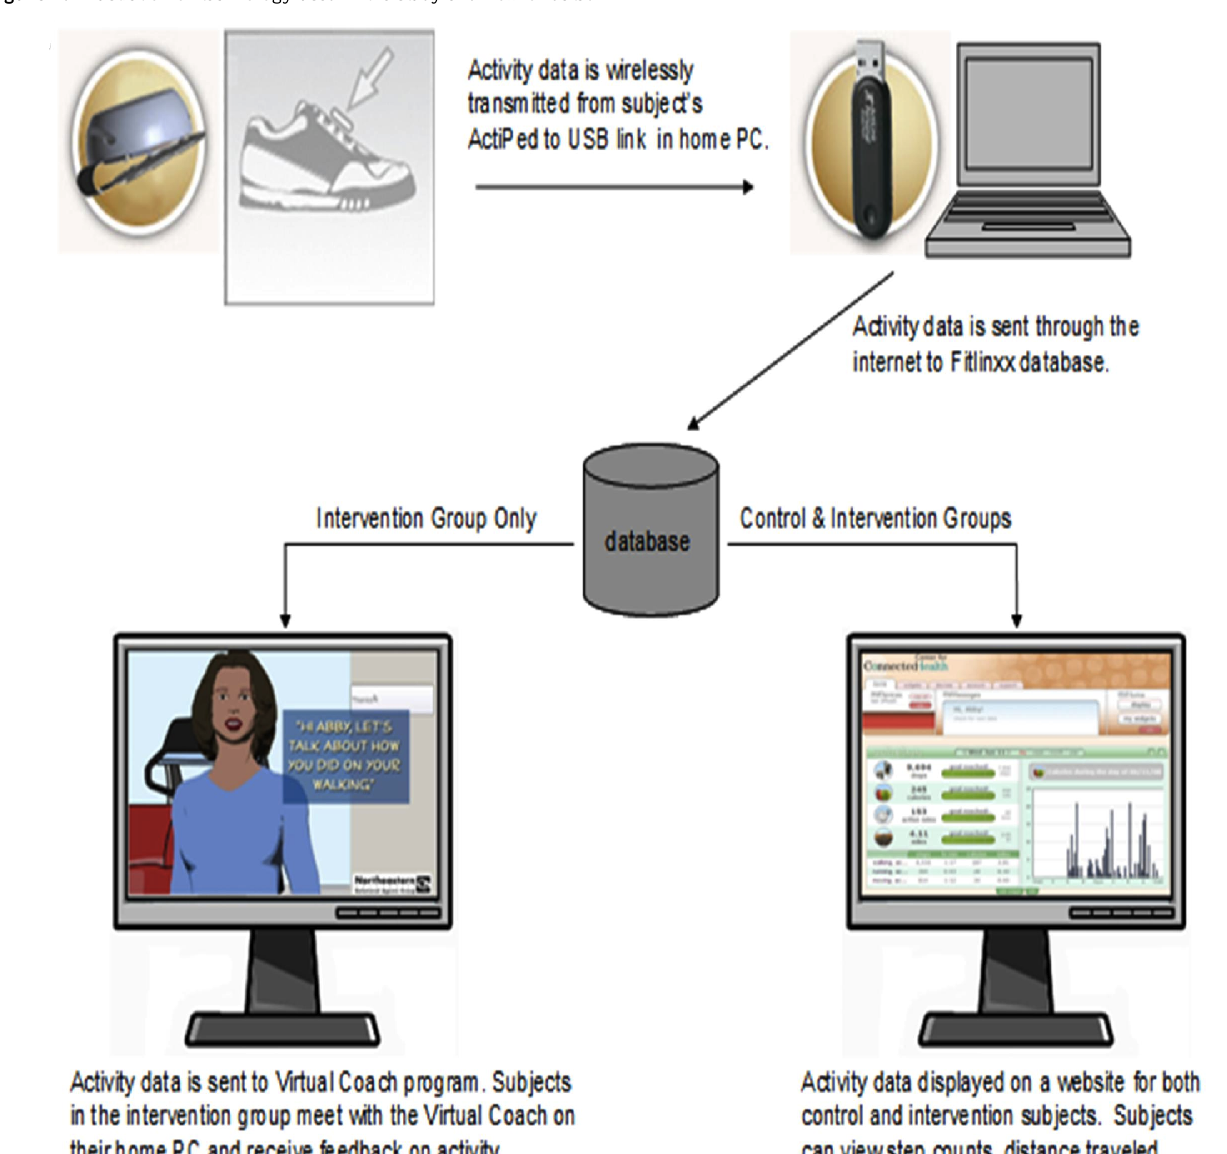
Figure 1. Illustration of technology used in the study and flow of